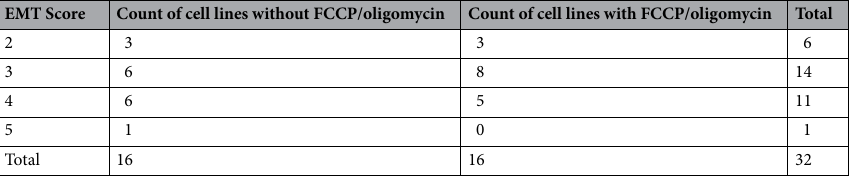
EMT Score Count of cell lines without FCCP/oligomycin Count of cell lines with FCCP/oligomycin